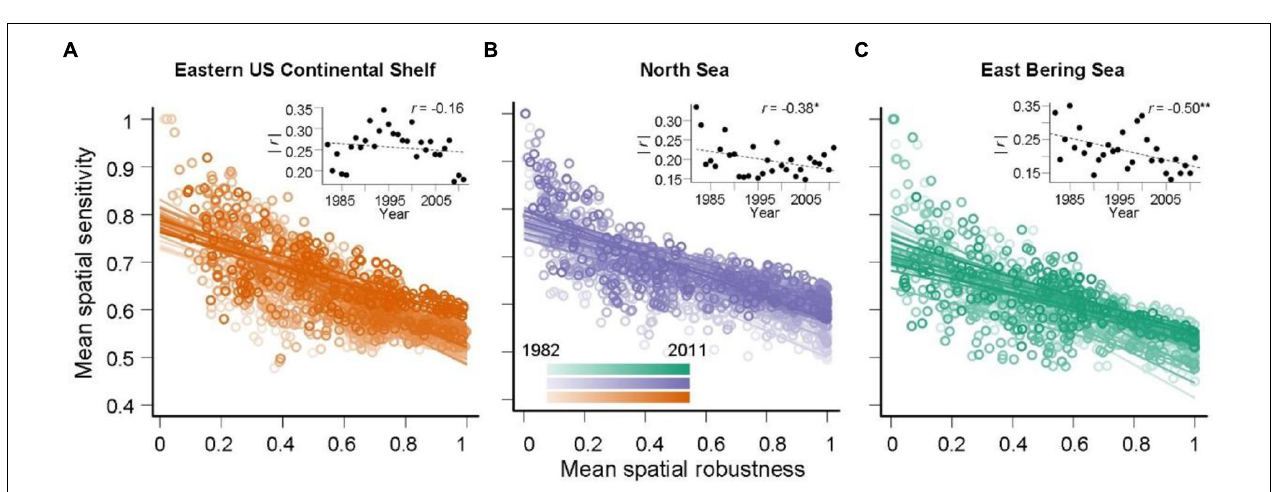
FIGURE 4 | Relationships between species’ mean spatial robustness and sensitivity in the (A) Eastern US Continental Shelf, (B) North Sea, and (C) Eastern Bering Sea large marine fish communities. The linear relationships between species’ mean spatial robustness and sensitivity for each year are plotted to display correlation patterns year-by-year. Darker points and solid lines represent later years. The right-top panels provide linear temporal correlations and asterisks indicate significance (* p < 0.05; ** p < 0.01).